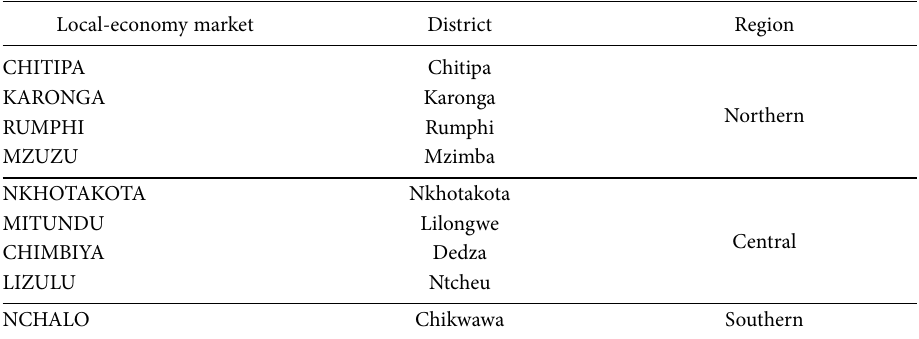
Table 1. Local-economy markets analysed by district and region.